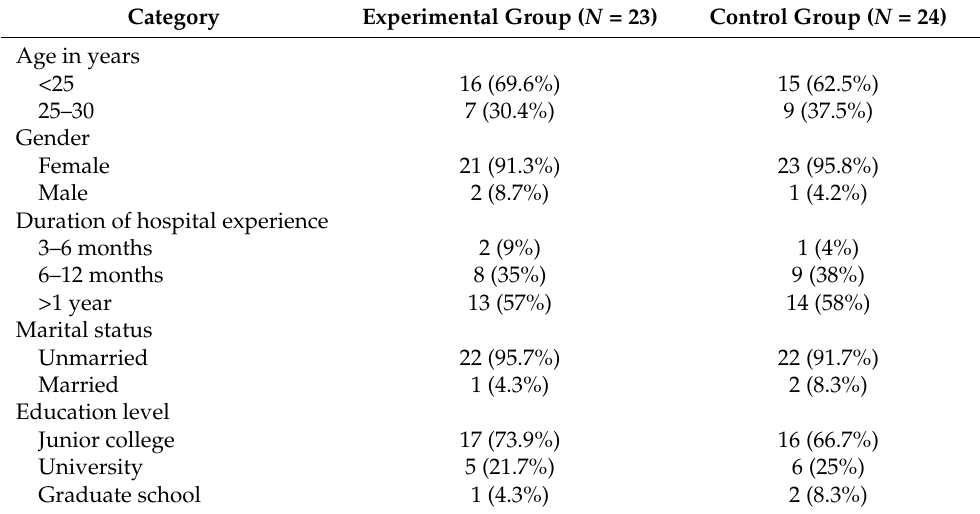
Table 1. Participant demographic data.